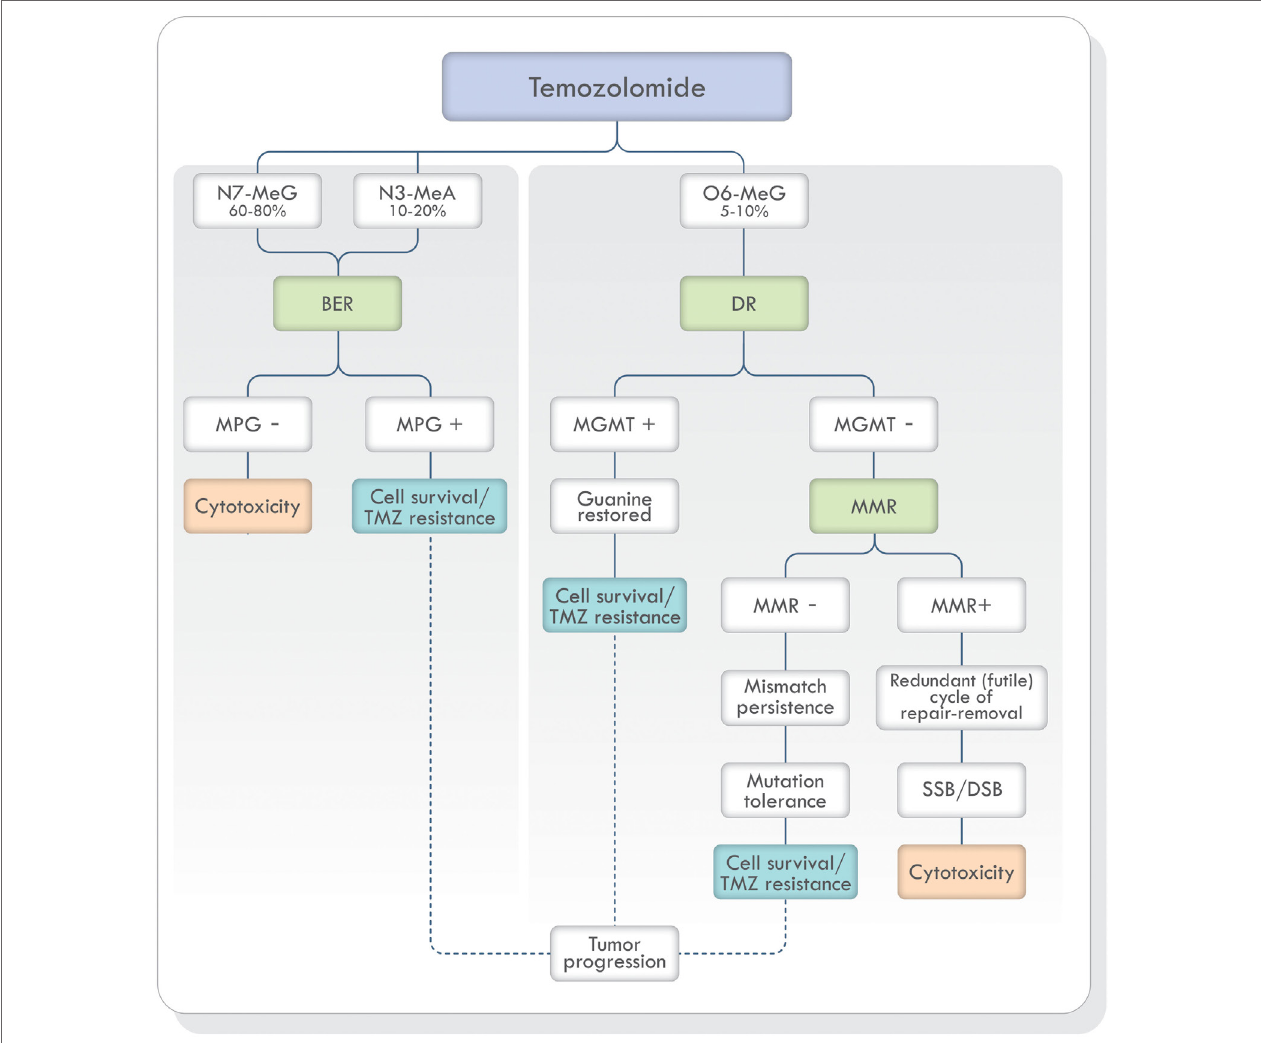
FiGURe 3 | TMZ action and DNA repair mechanisms involved in the prevention and correction of alkylation-induced DNA damage. Based on Ref. (19, 42, 47, 48). Abbreviations: BER, base excision repair; DR, direct repair; MMR, mismatch repair; NER, nucleotide excision repair; MPG, DNA methylpurine -N -glycosylase; MGMT, O6-methylguanine-DNA methyltransferase; TMZ, temozolomide; SSB, single-strand breaks; DSB, double-strand breaks; DNA, deoxyribonucleic acid.